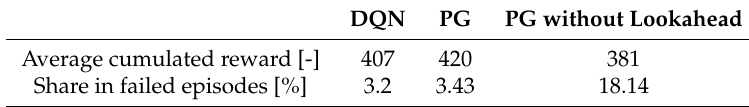
Table 3. Statistic performance of algorithms with and without lookahead sensor